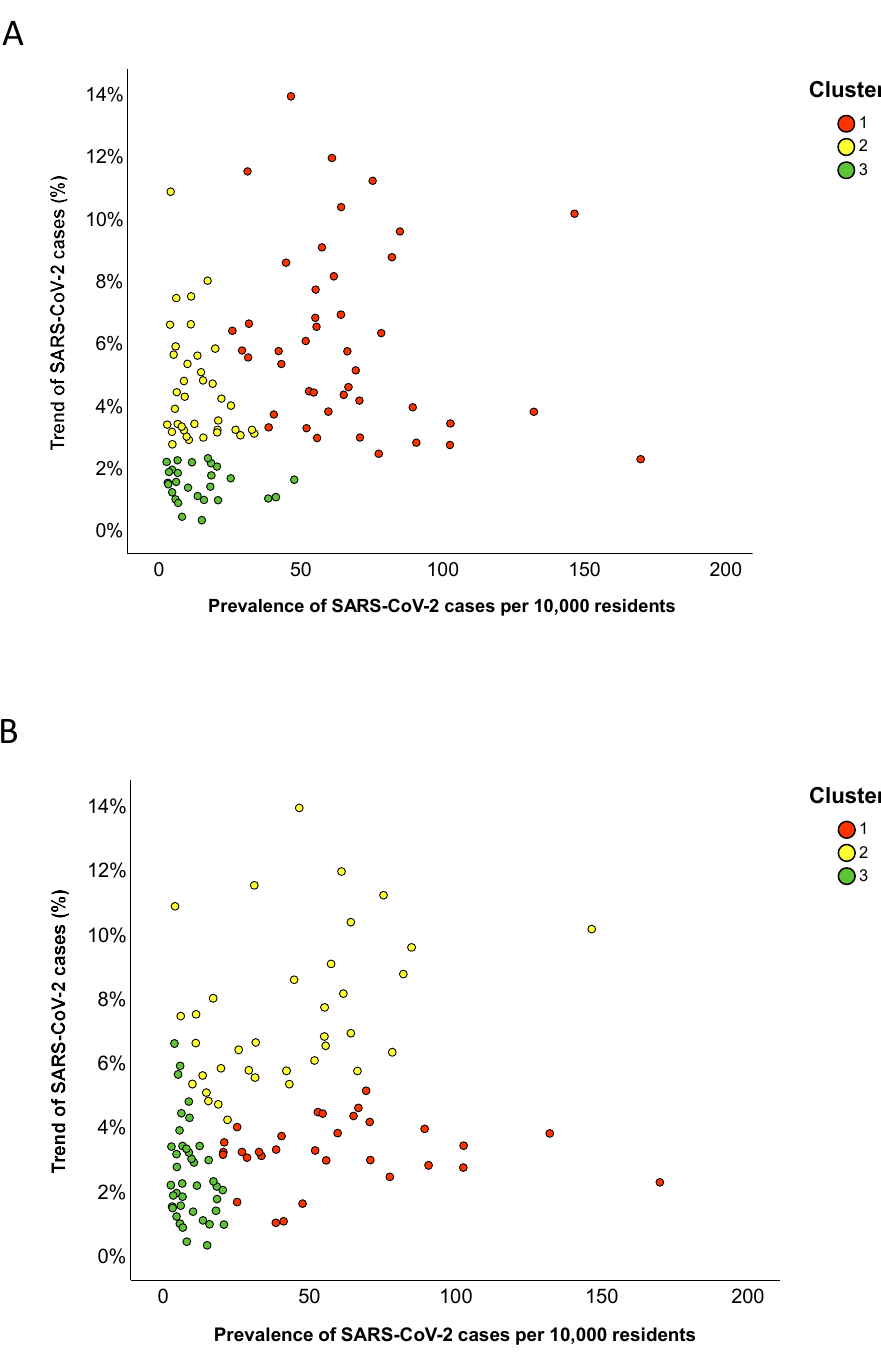
Figure 6. Scatter plot illustrating how provincial clusters were distributed on the prevalence of SARS-CoV-2 cases and their trend: ( A ) the clustering solution obtained by hierarchical clustering; and ( B ) the clustering solution obtained using the k-means algorithm.